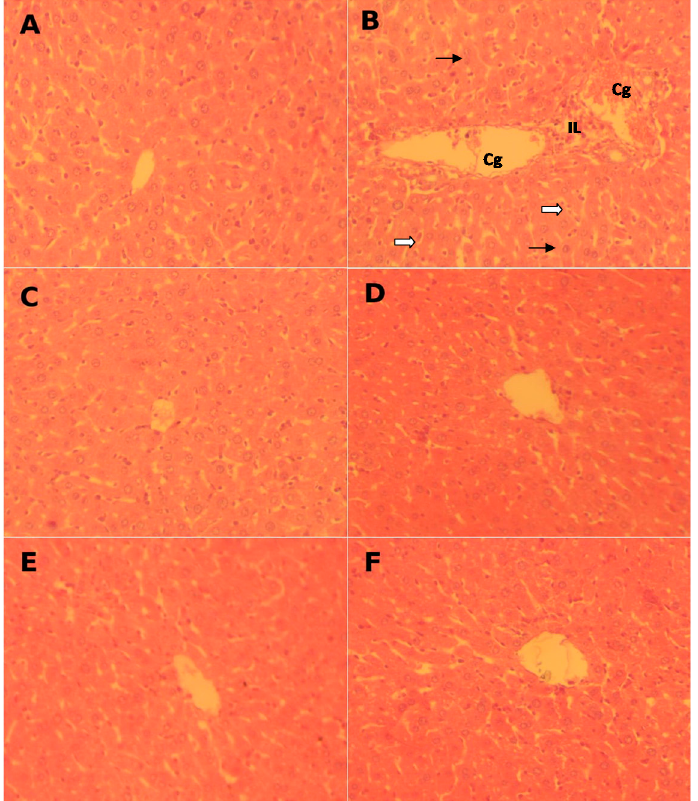
Figure 1. Pathological histology analysis in rat liver tissues after HE staining (magnification: 200×): ( A ) controls, ( B ) CCl 4 -treated (CCl 4 ); ( C ) FLE-treated (FLE), and ( D ) CCl 4 -treated co-treated with FLE (CCl 4 + FLE). ( E ) DLE-treated (DLE), and ( F ) CCl 4 -treated cotreated with DLE (CCl 4 + DLE). Each